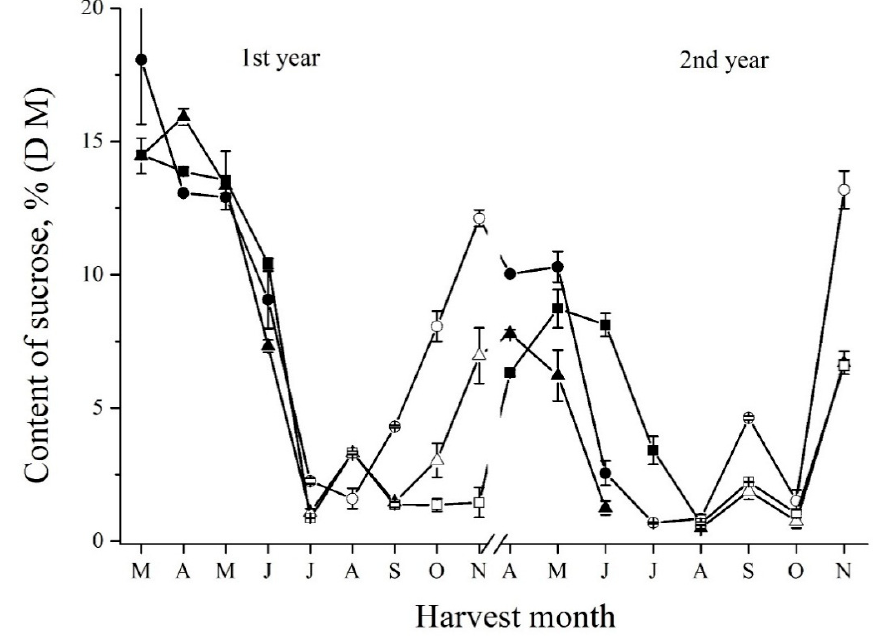
Figure 3. Seasonal fluctuations of sucrose determined by enzymatic method in the tubers of Sauliai ( ● , ○ ), Albik ( ▲ , ∆ ), and Rubik ( ■ , □ ); spring tubers: ● , ▲ , ■ ; summer and autumn tubers: ○ , ∆ , □ .